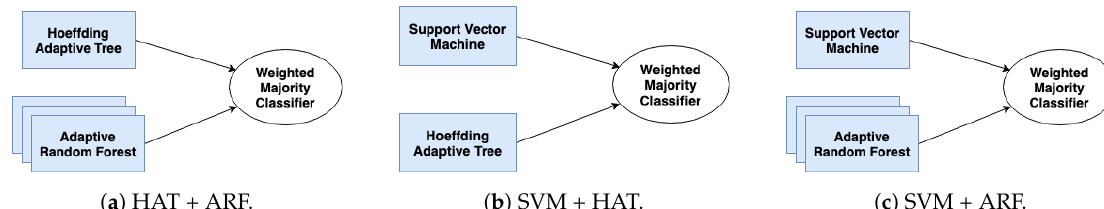
Figure 1. Proposed heterogeneous ensembles. Each subfigure shows the listed algorithms combined with a weighted majority